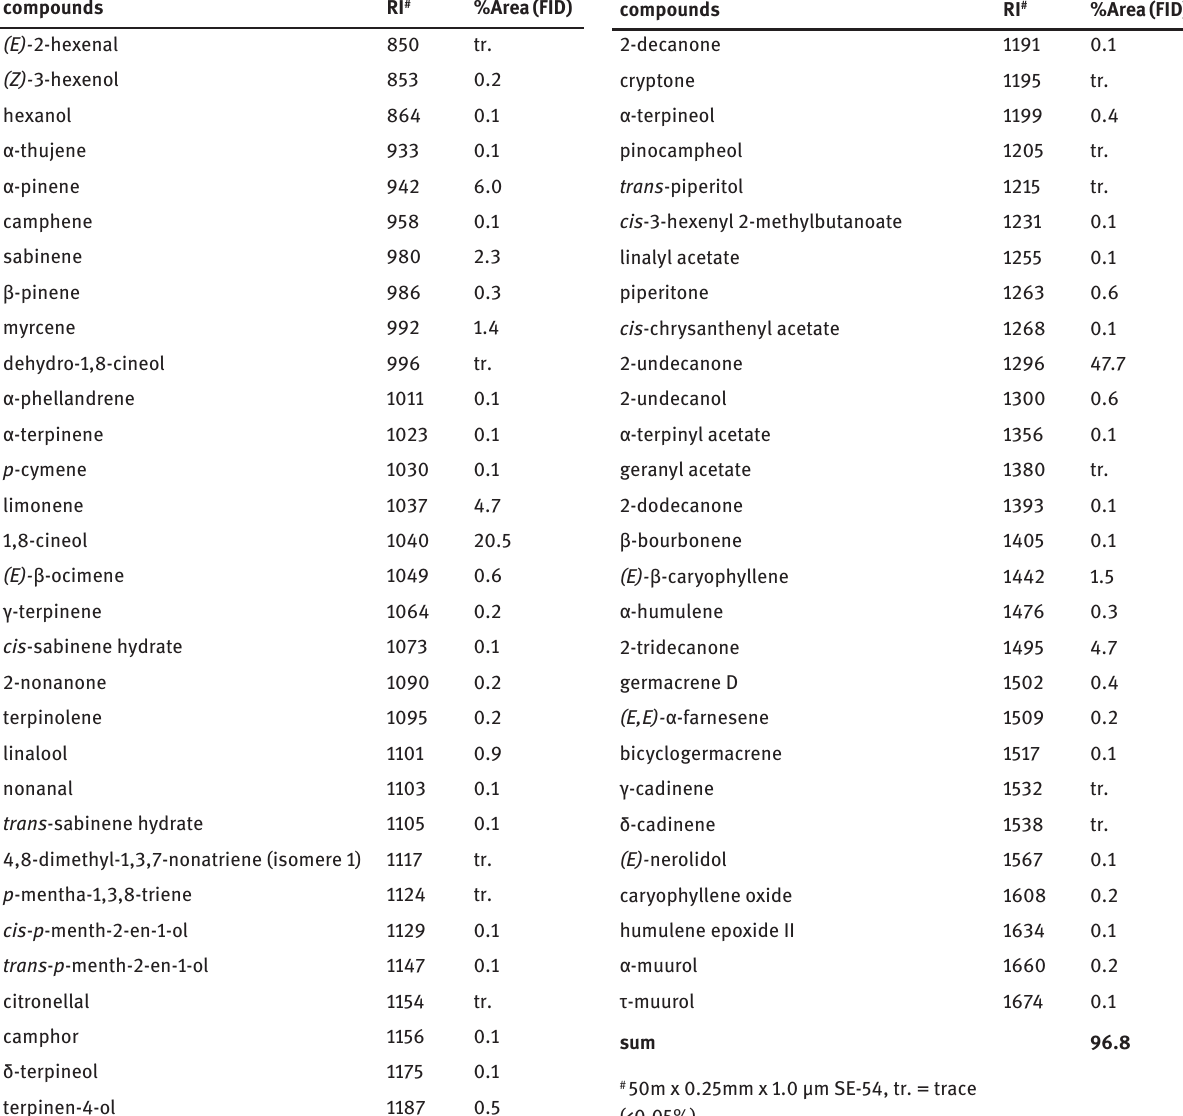
Table 1: Constituents identified in the essential oil of Zanthoxylum armatum analysed by GC-MS-FID.